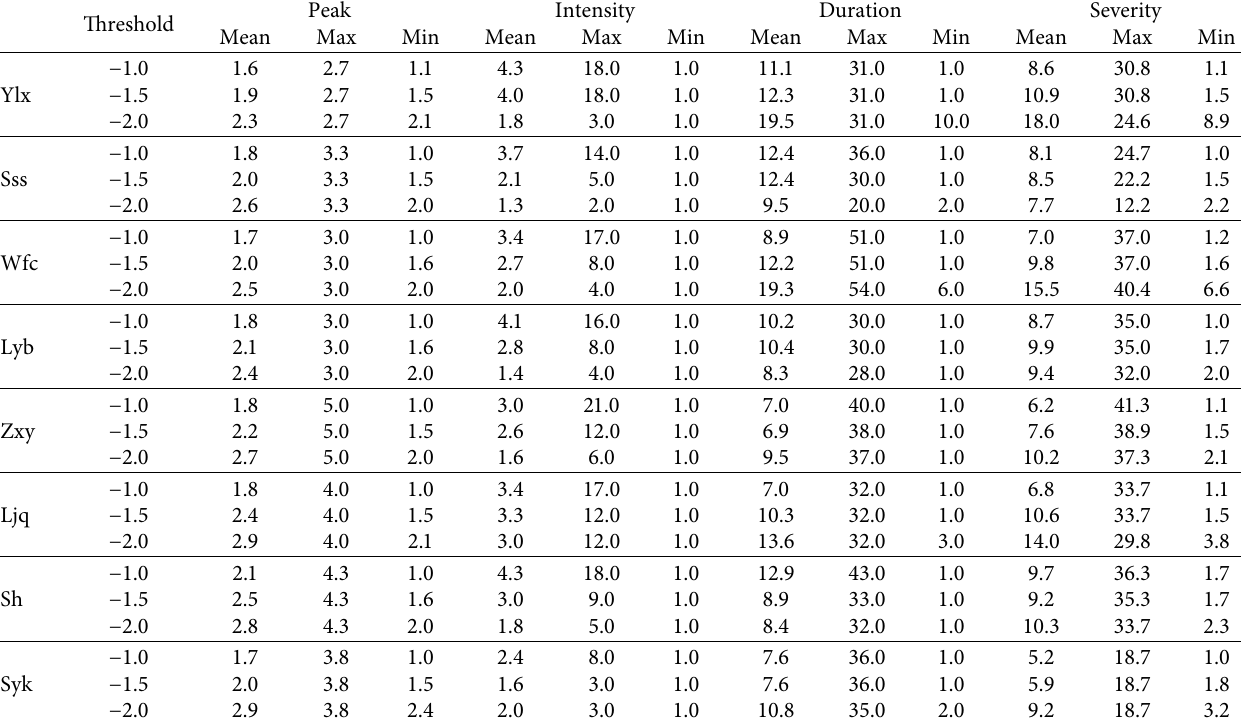
Table 5: The distribution of peak, intensity, duration, and severity for HD characteristics based on SDI-1 using thresholds of − 1, − 1.5, and − 2 in the UHRB and MHRB.